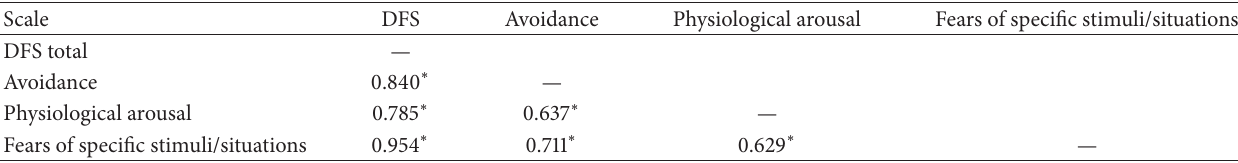
Table 3: Construct validity: rank correlations between scores of total scale and factors of the Brazilian version of the Dental Fear Survey (DFS) ( 𝑛 =